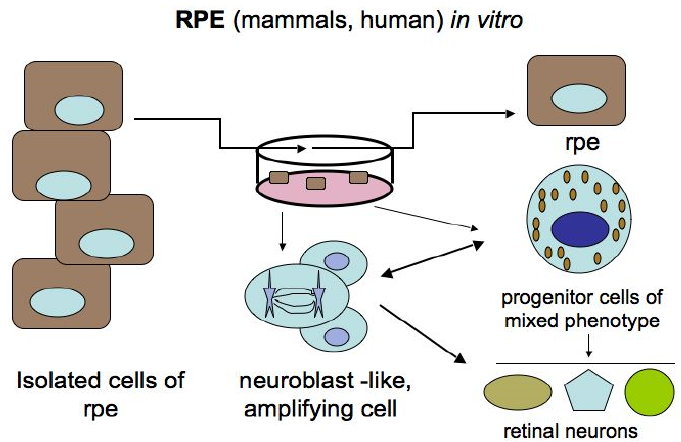
Figure 5. Phenotypic plasticity of mammalian retinal pigment epithelium cells in vitro. Different levels and types of differentiation were observed, dependent on cell culture conditions. More details are in the text.